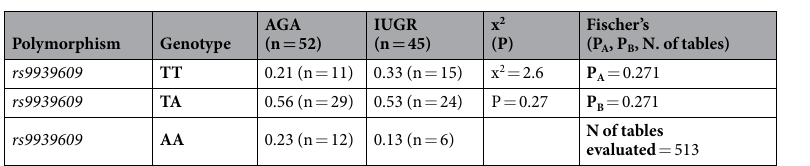
Table 6. Frequencies of the genotypes of the polymorphism in children born with IUGR compared to children born AGA, the x 2 and corresponding P values for 2 degrees of freedom and the Freeman-Halton extension of the Fisher exact probability test, for two-rows by three-column contingency